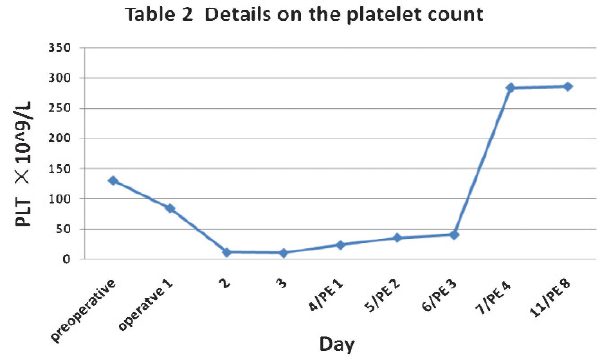
Table 1 - Patient body temperature over the course of treatment.